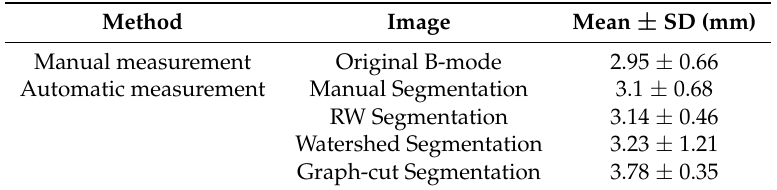
Table 2. Quantitative results for automatic cartilage-thickness